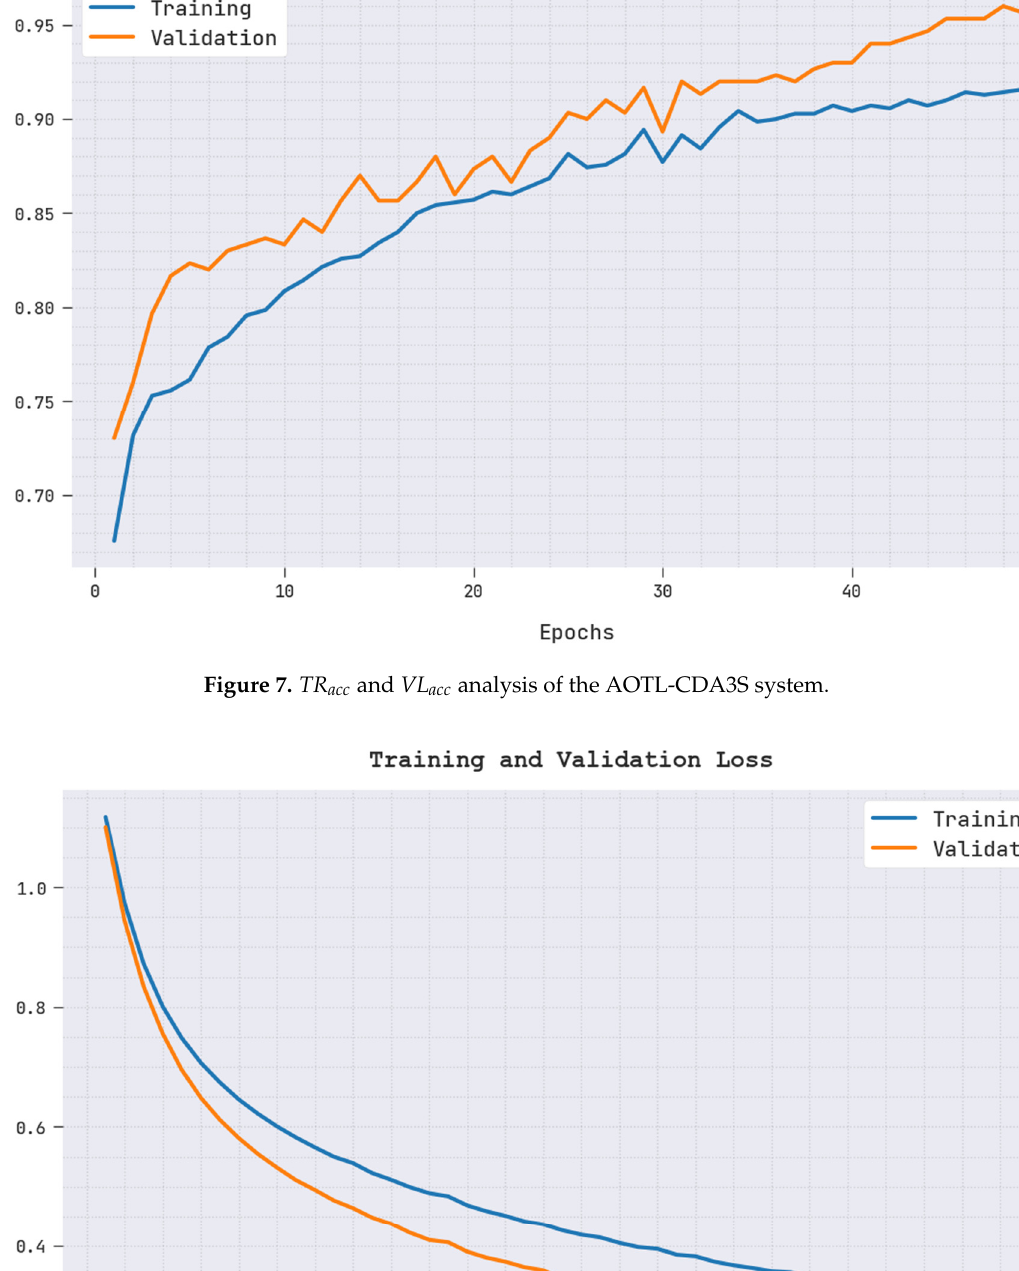
Figure 8. TR loss and VL loss analysis of the AOTL-CDA3S system.